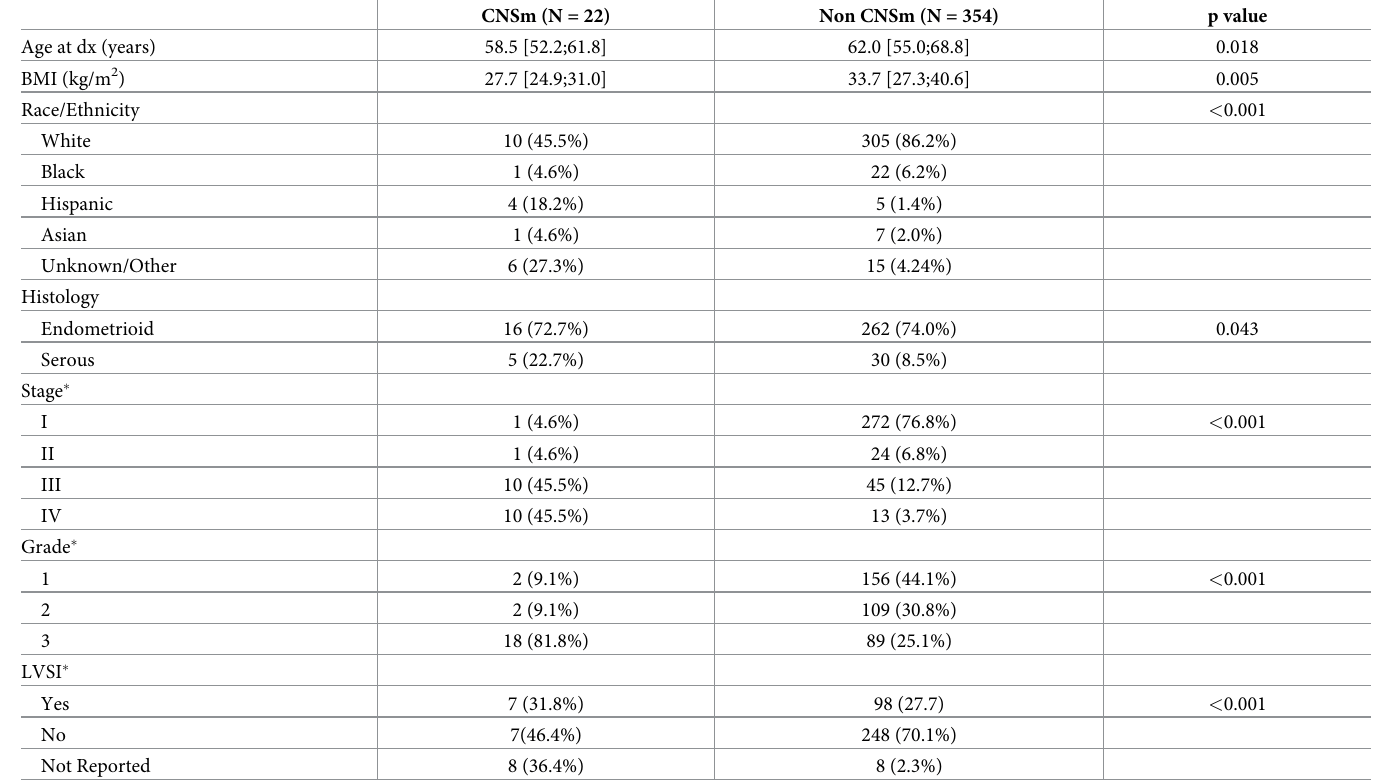
Table 2. Endometrial cancer patients with CNS metastasis compared to control cohort without CNS metastasis.